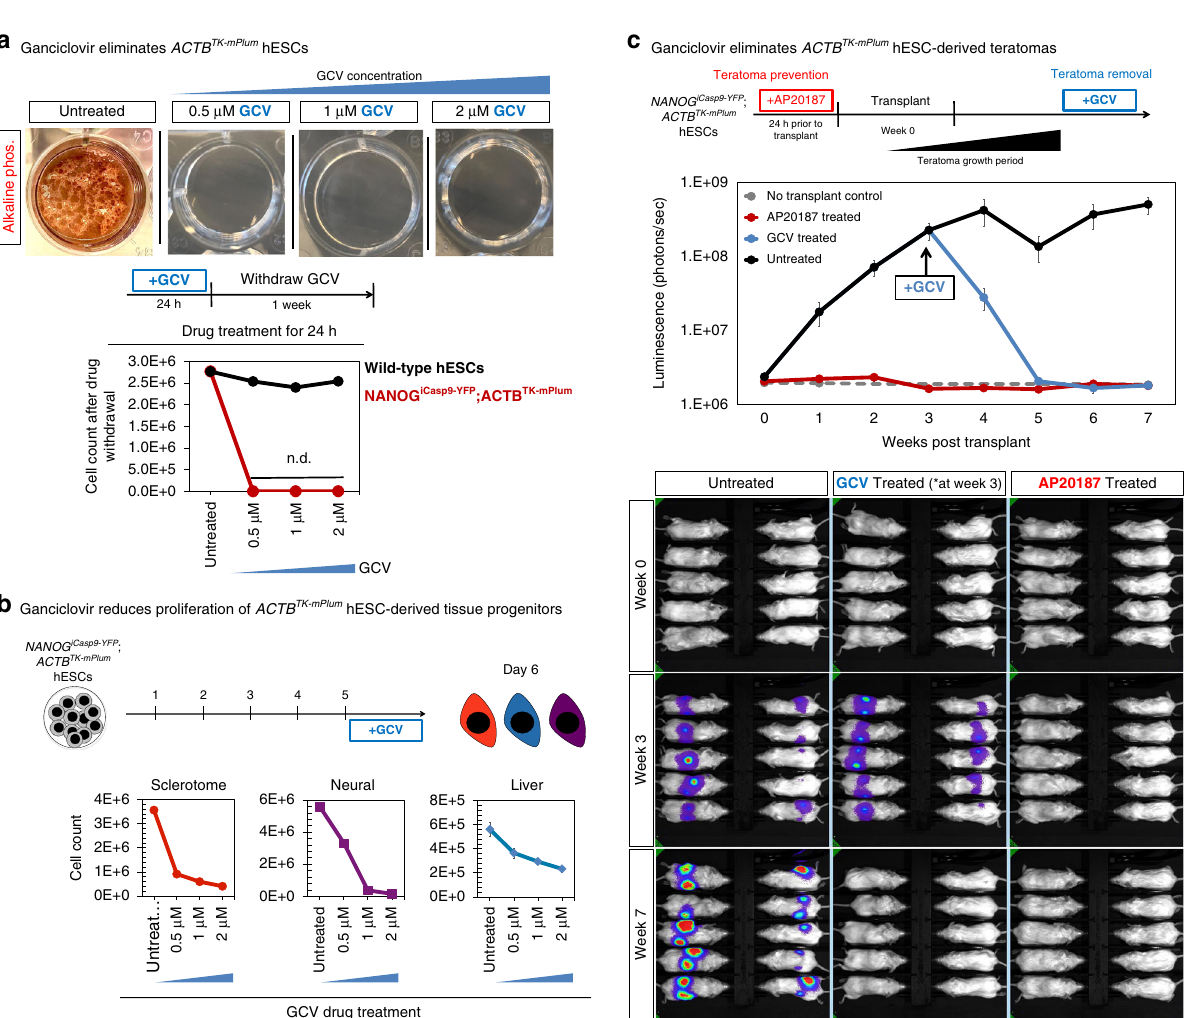
Fig. 5 Implementation of the ACTB TK-mPlum safety switch. a NANOG iCasp9-YFP ; ACTB TK-mPlum hESCs were treated with ganciclovir (or left untreated) for 24 h, and subsequently ganciclovir was withdrawn and hESCs were cultured for 1 week in mTeSR1 to detect any surviving cells and to allow them to regrow. Alkaline phosphatase staining of whole wells of a 12-well plate for each condition ( top ) and cell counts for wild type and NANOG iCasp9-YFP ; ACTB TK-mPlum hESCs after each treatment ( bottom ) demonstrated the elimination of hESCs. N.D. = not detected. b NANOG iCasp9-YFP ; ACTB TK-mPlum hESCs were differentiated into day 6 liver, sclerotome, and neural progenitors and treated with ganciclovir at the indicated doses for the last 24 h of differentiation. Cell survival was analyzed by counting at day 6 of differentiation. c 10 6 NANOG iCasp9-YFP ; ACTB TK-mPlum hESCs engineered to express CAG-AkaLuciferase were treated with control media or 1 nM AP20187 for 24 h, and then subcutaneously transplanted into the right and left dorsal fl anks of NOD-SCID Il2rg − / − mice (10 6 cells per fl ank). After 3 weeks post-transplant, teratomas formed in vivo and ganciclovir was administered daily at 50 mg/kg until week 7 post- transplant. Bioluminescent imaging of mice was conducted weekly for 7 weeks. Total fl ux (photons/s) was measured for each animal and were averaged (bioluminescent quanti fi cation and images for each individual animal from week 0 – 7 are in Supplementary Fig. 4c). Source data are available in the Source Data fi